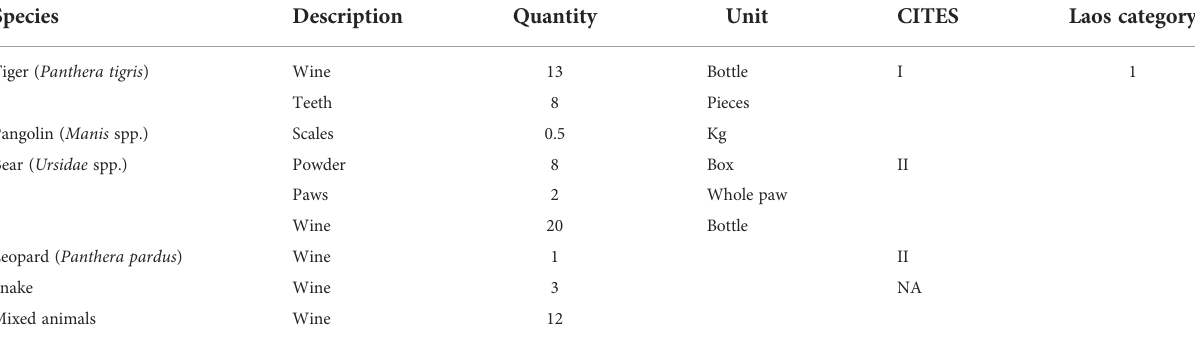
TABLE 2 Wildlife trade in Boten SEZ, Laos — the endangered species in the wildlife shops and wild meat restaurants in 2019. Species